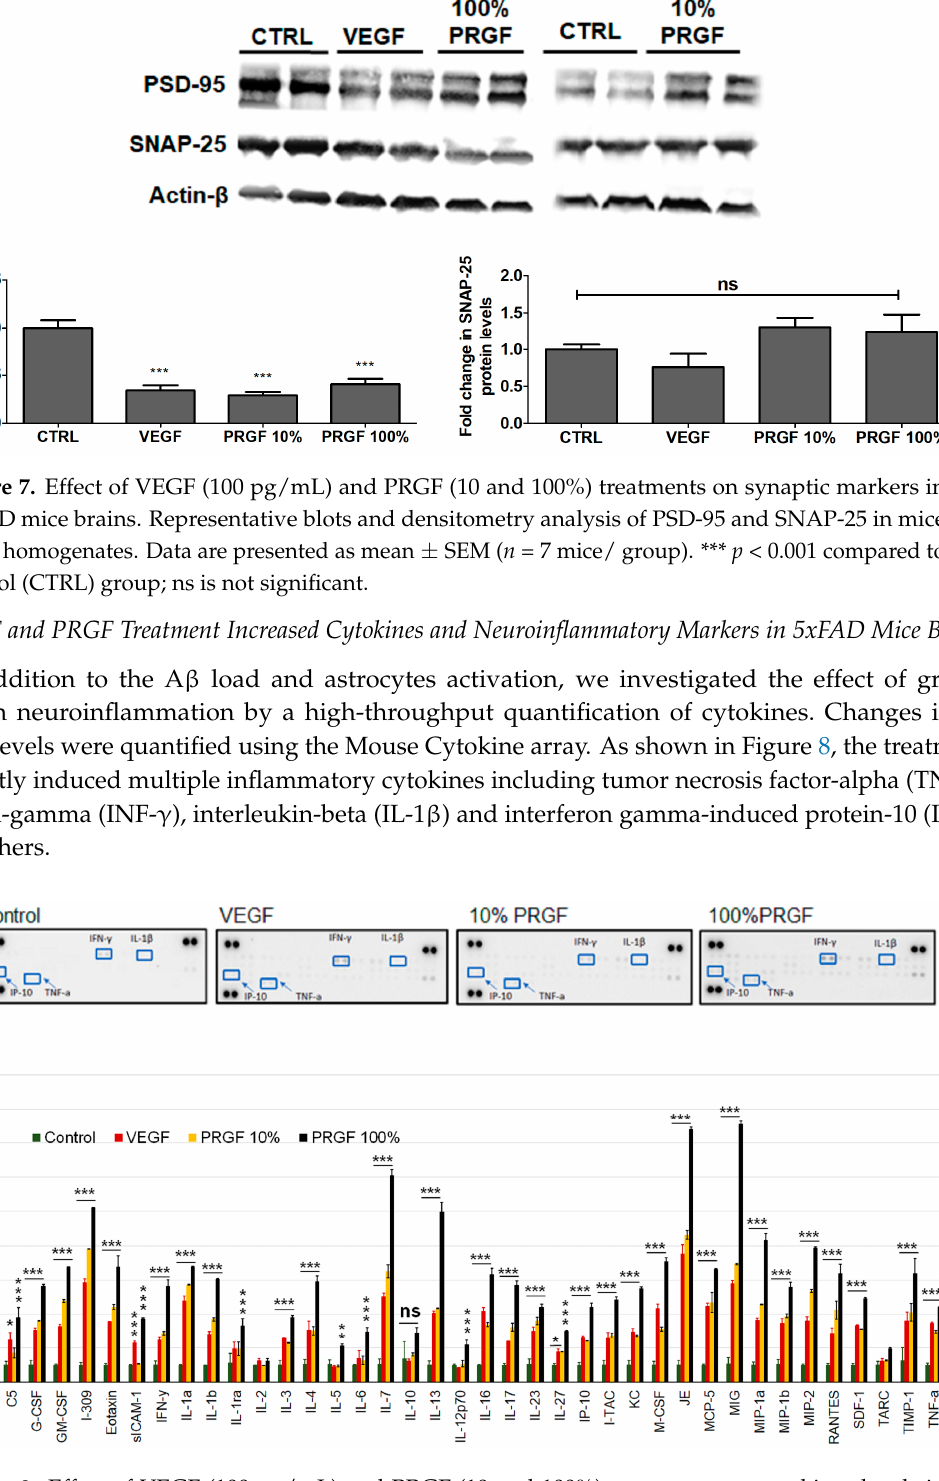
5xFAD mice brain homogenates as measured by cytokine array. Data are presented as an average of